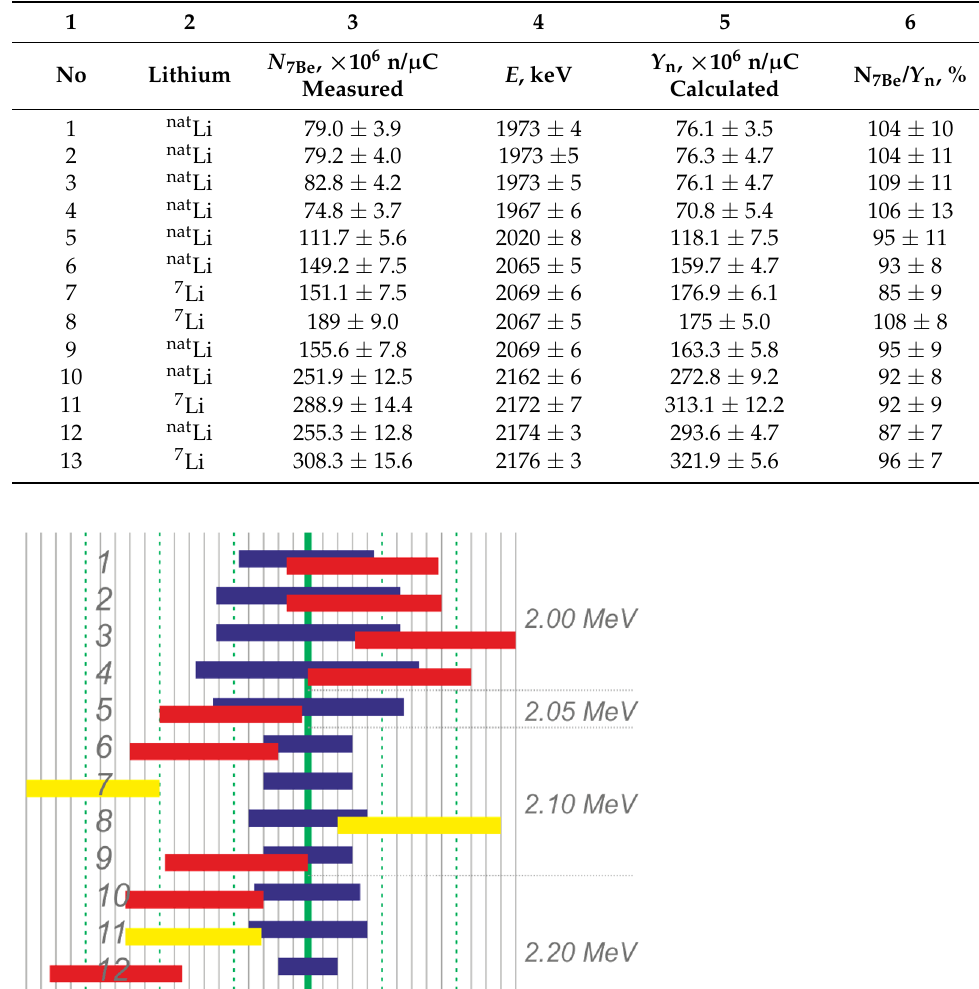
Table 3. Data on the measurements of the target. Columns: 1—serial number of targets; 2—the type of lithium used (natural or enriched with the lithium-7 isotope); 3—measured number of 7 Be nuclei; 4—the actual proton energy; 5—calculated number of neutrons; 6—the ratio of the measured number of beryllium-7 nuclei to the calculated number of neutrons, %.